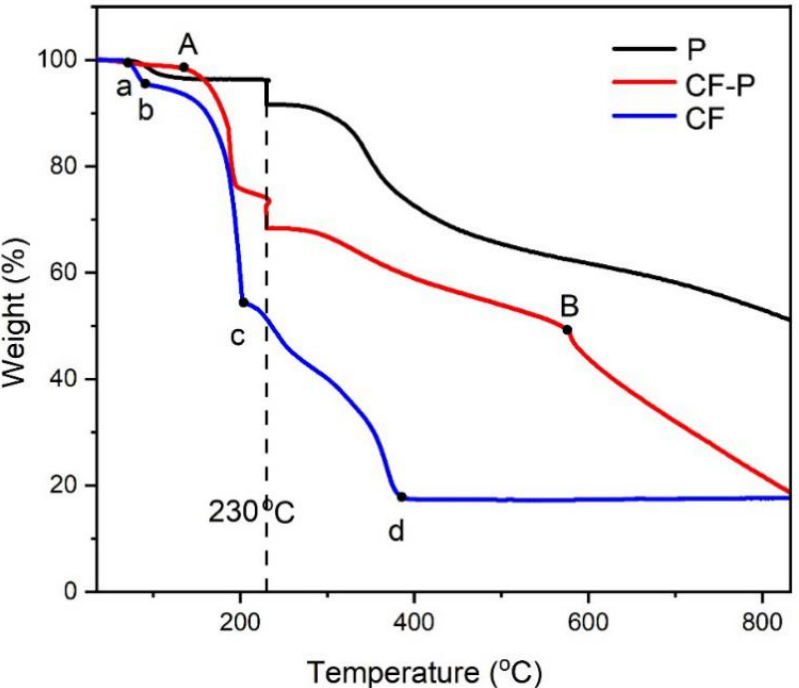
Figure 5. Thermogravimetric curves of PAN fiber membrane (P), C 15 H 21 CoO 6 (Co(acac) 2 ), C 15 H 24 FeO 6 (Fe(acac) 3 ) mixed powder (CF) and C 15 H 21 CoO 6 (Co(acac) 2 )/C 15 H 24 FeO 6 (Fe(acac) 3 )/PAN heterogeneous submicron fiber membrane (CF-P). In Figure 6, a, b, c and d are the inflection points of the TG curves of C 15 H 21 CoO 6 (Co(acac) 2 ) and C 15 H 24 FeO 6 (Fe(acac) 3 ) powder mixtures. A and B are the inflection points of the TG curve of the C 15 H 21 CoO 6 (Co(acac) 2 )/C 15 H 24 FeO 6 (Fe(acac) 3 )/PAN heterogeneous submicron fiber membrane.